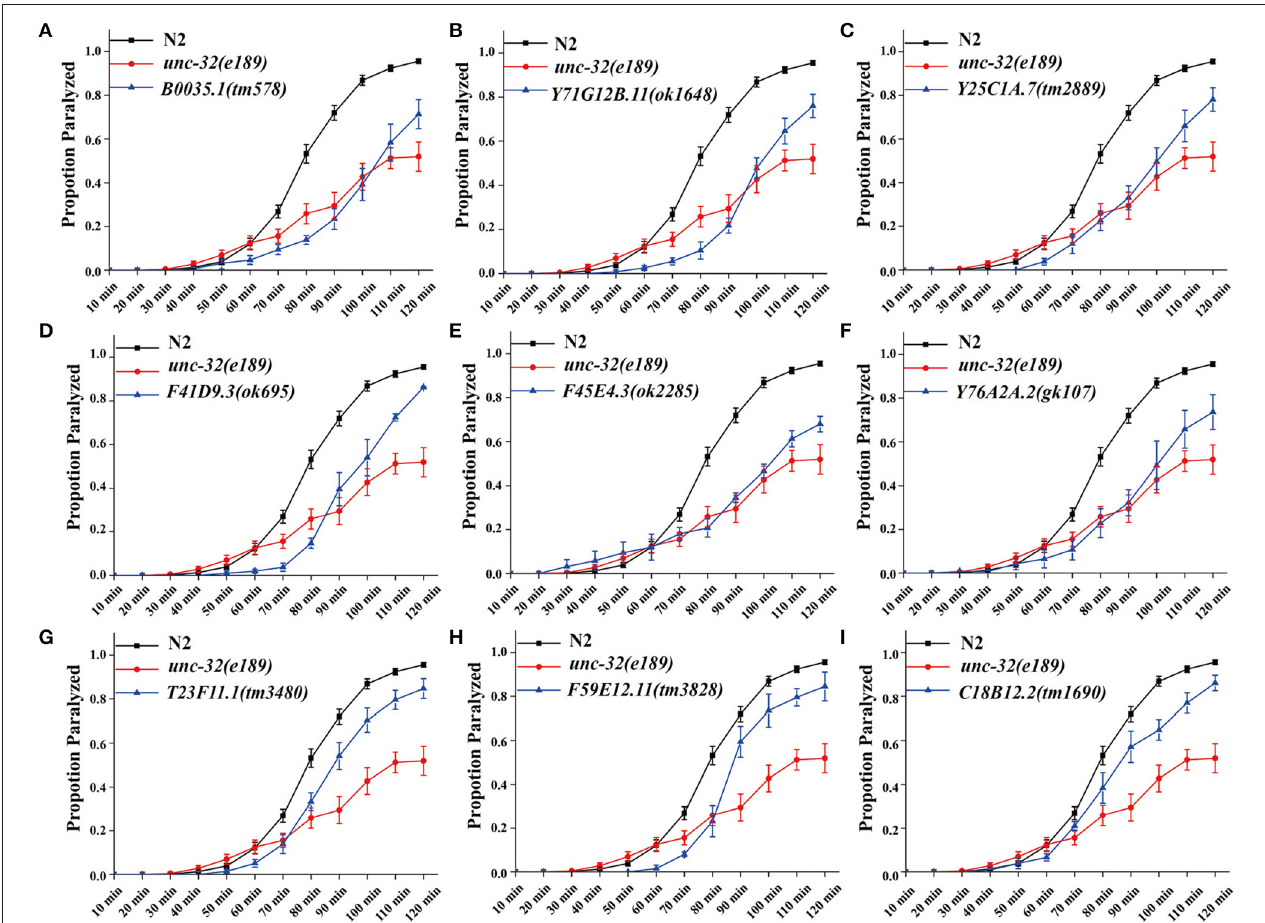
FIGURE 2 | Deletion mutants of candidate genes show acetylcholine secretion defects. Acetylcholine release was detected by determining the proportion of paralyzed animals exposed to 1 mM aldicarb. (A–I) Proportion paralyzed over time from indicated deletion mutant worms. Worm strains of B0035.1(tm578) , Y71G12B.11(ok1648), Y25C1A.7(tm2889) , F41D9.3(ok695) , F45E4.3(ok2285), Y76A2A.2(gk107), T23F11.1(tm3480) , F59E12.11(tm3828) , and C18B12.2(tm1690) exhibited aldicarb-resistance. UNC-32(e189) as aldicarb resistant positive control. 25–35 young adult animals were tested for each experiment, at least three independent experiments were performed. Error bars represent